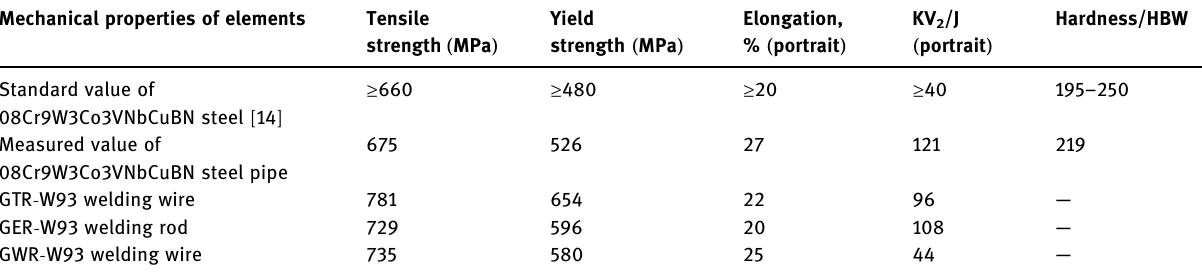
Table 2: Mechanical properties of the 08Cr9W3Co3VNbCuBN pipe and welding electrodes Mechanical properties of